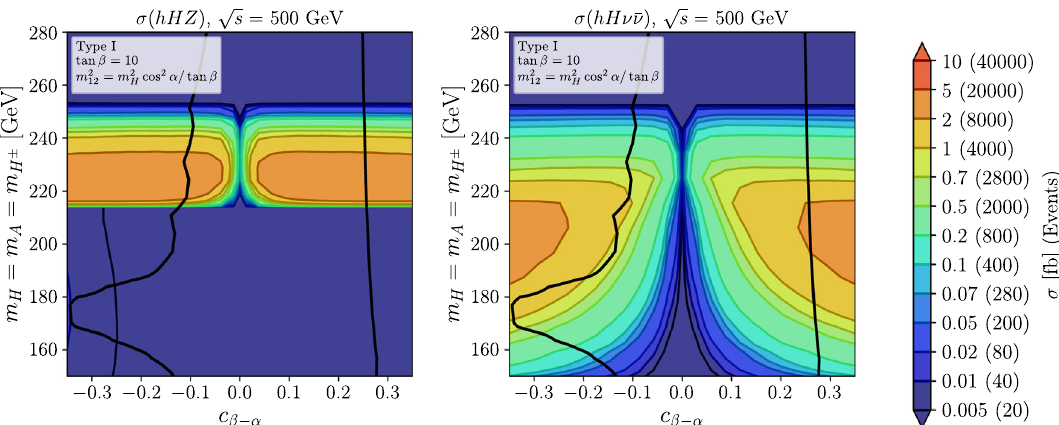
√ s = 500 GeV for our benchmark plane 3. The total allowed regions √ s = 500